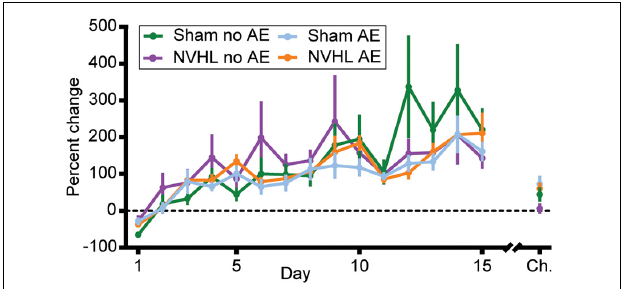
FIGURE 5 | Percentage change in distance traveled. The level of nicotine sensitization was determined by calculating the percentage change in distance traveled from the preinjection phase to the first 30 min of the postinjection phase across each of the initial 15 sessions and on the challenge day for each rat. No group differences were observed but a significant effect of day across the 15 sessions indicates that all groups became sensitized to nicotine. Data is shown as group mean ± SEM.